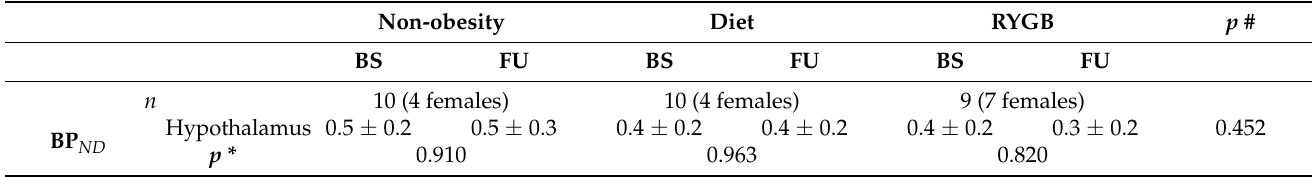
Table 3. 5-HTT BP ND values of study participants at baseline (BS) and follow-up (FU) allocated to the type of intervention.